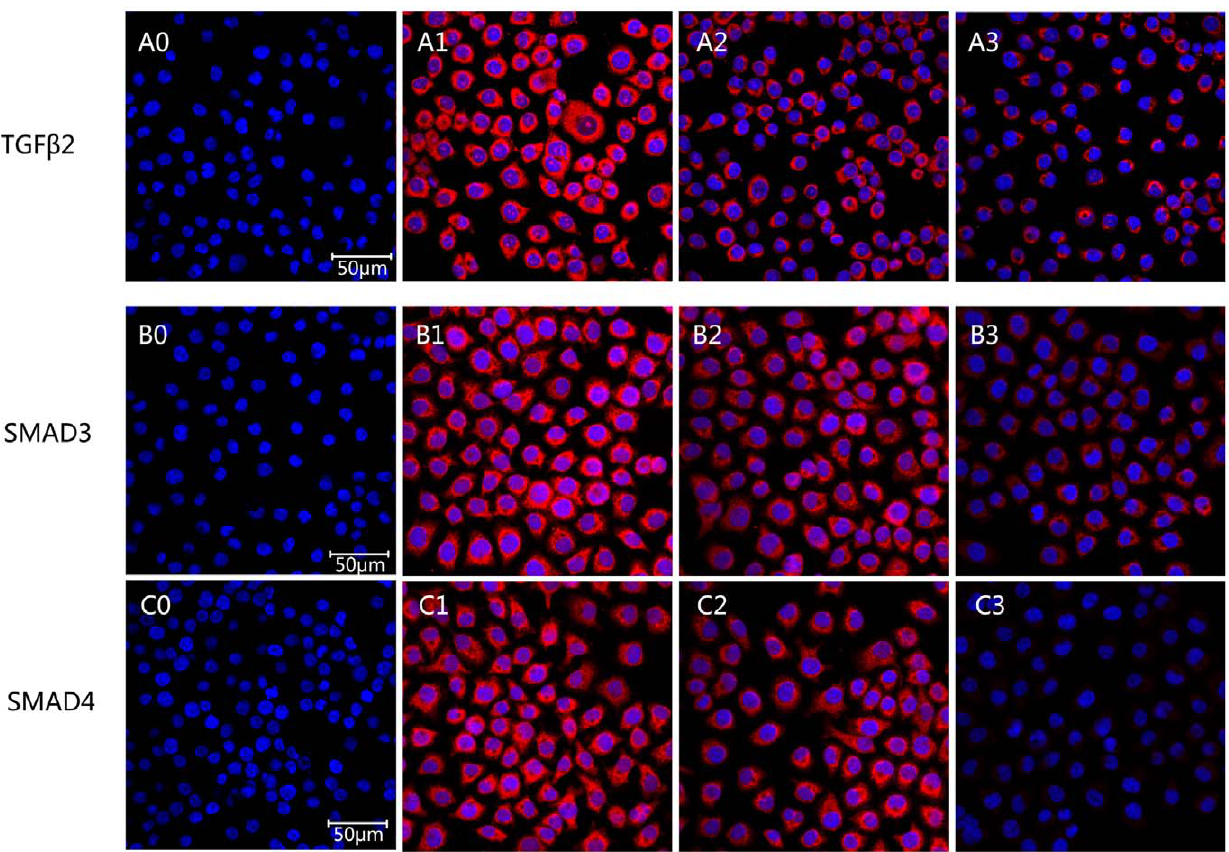
Figure 9. Expression of TGF b 2 and SMADs protein in SRA01/04 cells after treated with pirfenidone by immunocytochemical detection under confocal microscopy. TGF b 2 (A), SMAD3 (B), and SMAD4 (C) in the cytoplasm (red) and nuclei (blue) of HLECs were stained by immunocytochemistry after treatment with 0.25 (A2, B2, C2) and 0.5 mg/mL (A3, B3, C3) pirfenidone, respectively. (A0, B0, C0) Corresponding negative controls. Magnification, 6 400.